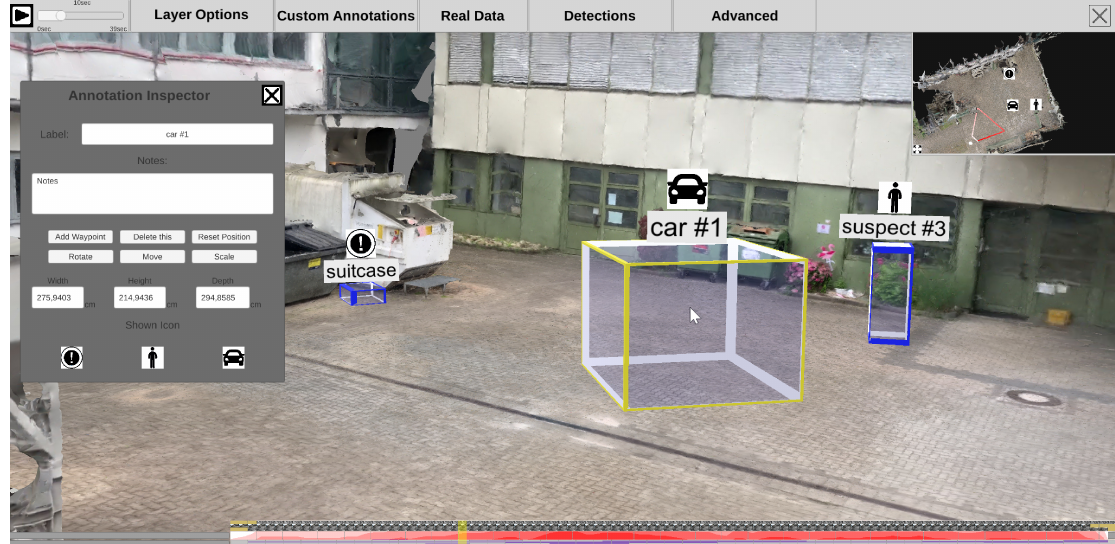
Figure 17. Static user annotations can be manually added to the